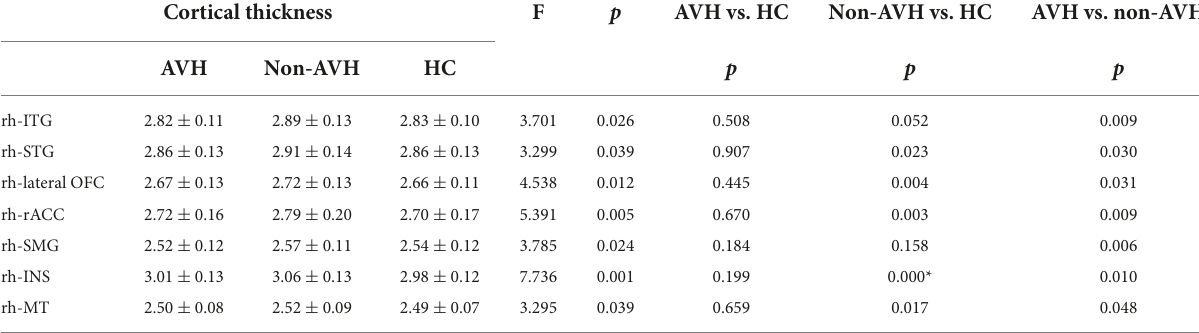
TABLE 3 Comparisons of cortical thickness among three groups.